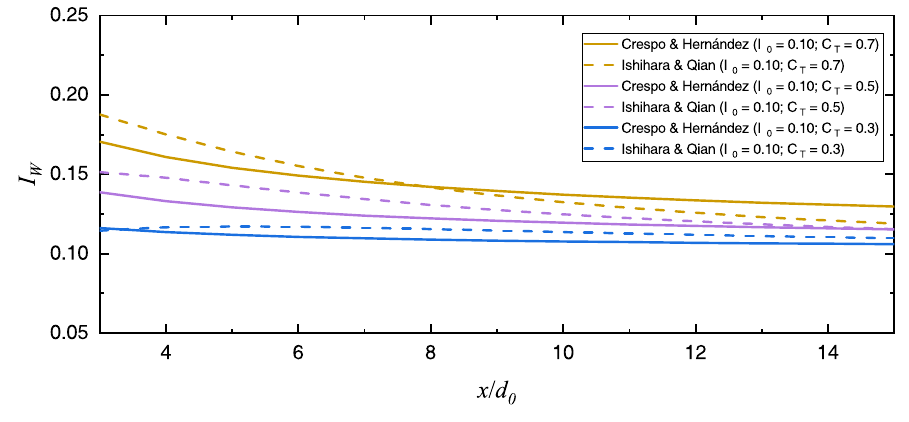
Figure 4. Turbulence intensity at the top tip height estimated by the Crespo and Hernández model and the Ishihara and Qian